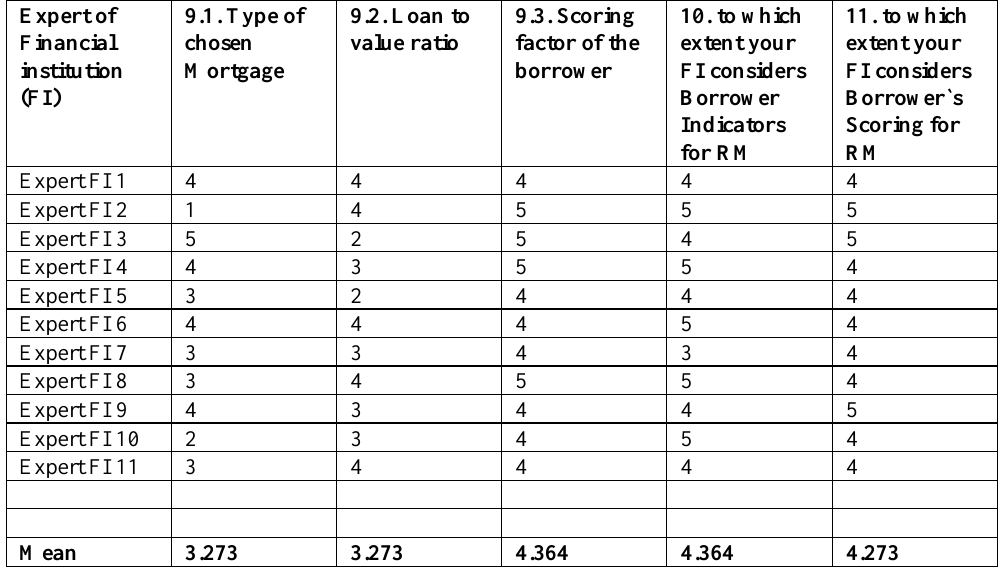
Table 5. Borrower Indicators for Credit Defaults (developed by the author) Expert of